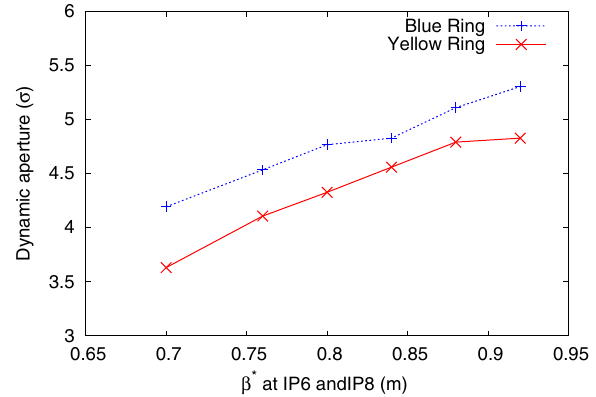
Blue: Below Diagonal Blue: Above Diagonal Yellow: Below Diagonal Yellow: Above Diagonal